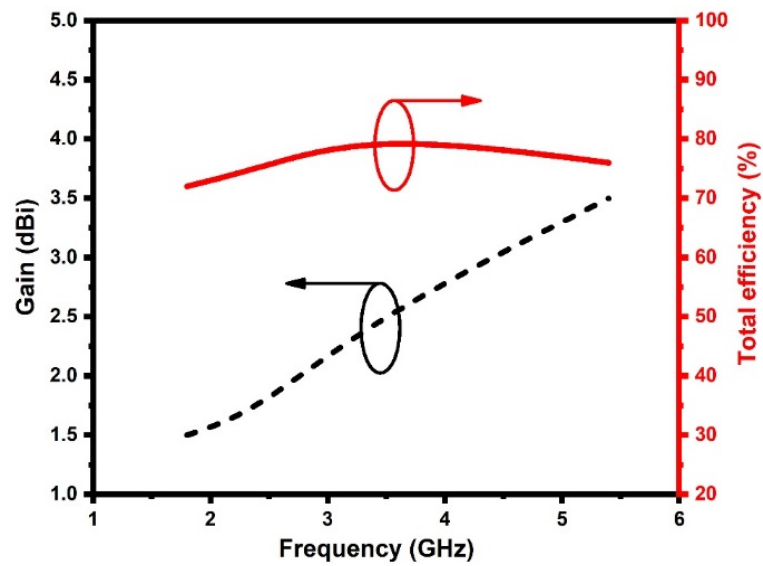
Figure 10. Measured gain and efficiency of the DS MIMO antenna.